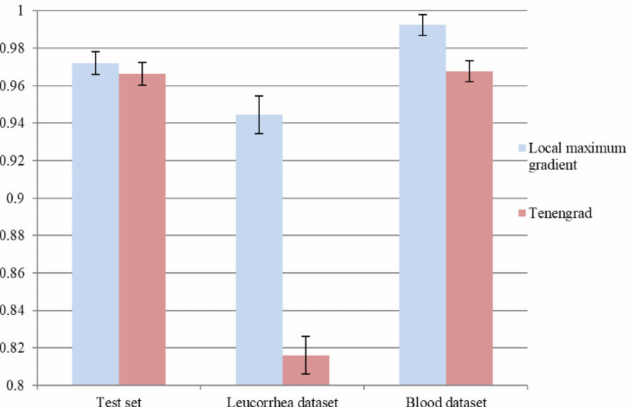
Figure 10. The influence on model performance of using Tenengrad method to compute atten- tion